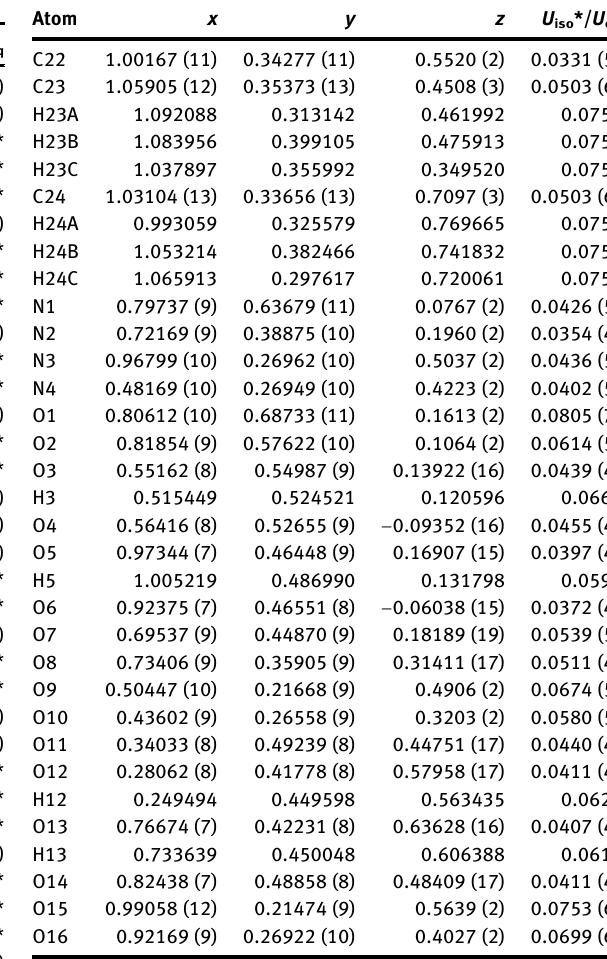
Table  : Fractional atomic coordinates and isotropic or equivalent isotropic displacement parameters (Å 